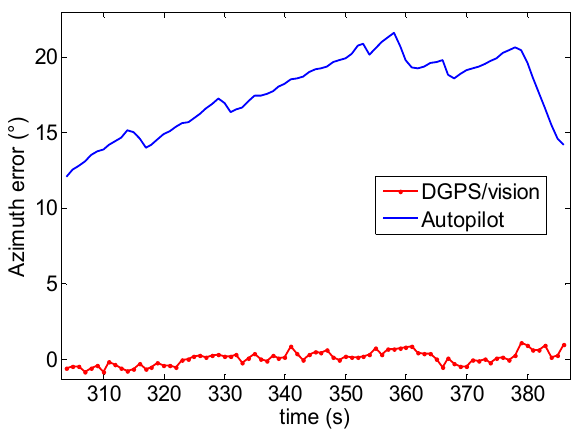
Figure 25. A zimuth error (°) as a function of time (Test 1-time frame 2). Figure 25. Azimuth error ( ◦ ) as a function of time (Test 1-time frame 2). Table 5. Azimuth error (°) comparison ( Table 5. Azimuth error ( ◦ ) comparison ( ∆ Az DGPS / Vision , ∆ Az Autopilot ) Test 1. Time Intervals ∆ Az DGPS / Vision Mean ∆ Az DGPS / Vision Std. ∆ Az Autopilot Mean ∆ Az Autopilot